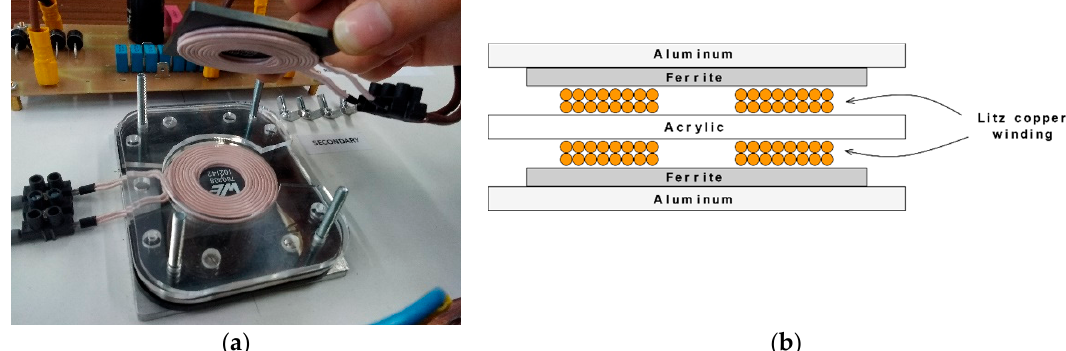
Figure 9. Coil stack used in the 150 W WPT prototype: ( a ) Photo, partially disassembled; ( b ) Stack cross section schematics.